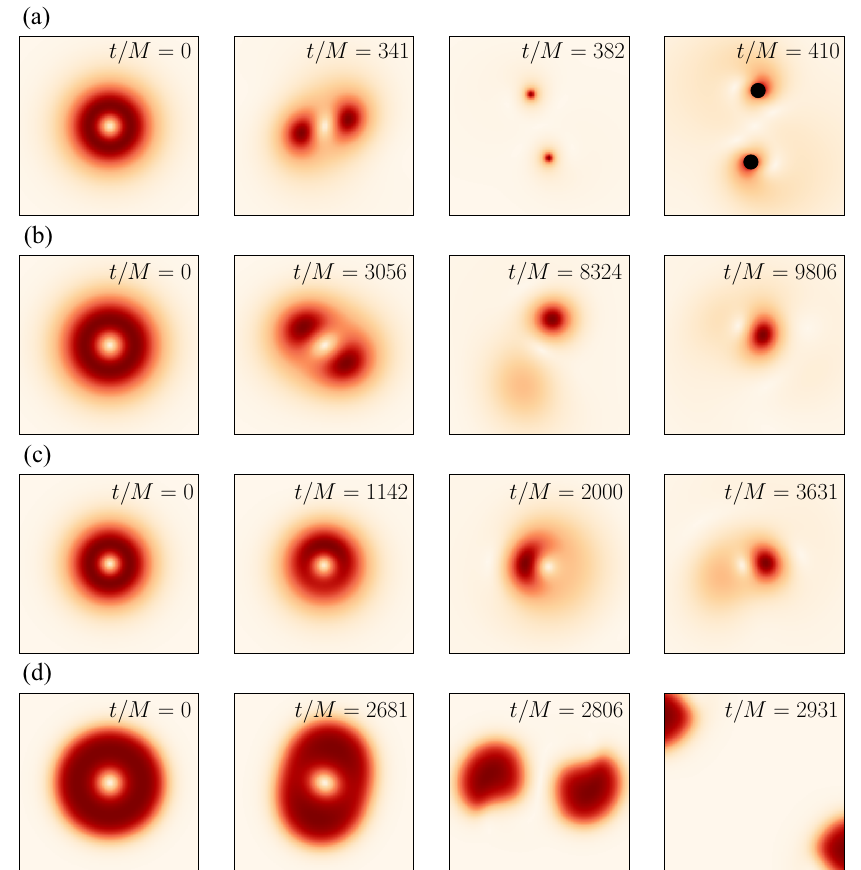
Fig. 20 Series of snapshots showing the evolution of j / j 2 in four scenarios where an unstable rotating BS with k ¼ 1 undergoes the NAI reaching different end states. From top to bottom: a a mini-BS that collapses to a binary BH (the regions inside the apparent horizons are indicated in black), b a rotating mini-BS resulting in a non-rotating with non-negligible linear momentum, c a BS with strong self-interaction yielding a non-rotating BS with large linear momentum, and d an axion BS where the NAI results in the fragmentation of the star into two equal-mass non-rotating BSs. Reproduced with permission from Siemonsen and East (2021), copyright by